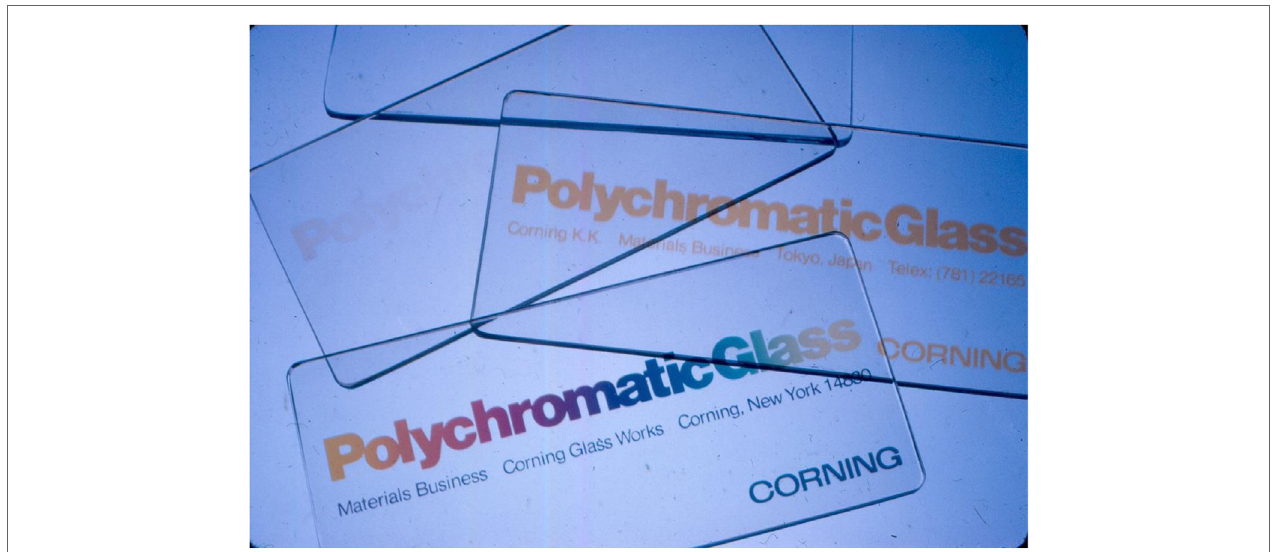
FiGURe 11 | evolution of polychromatic glass as formed, after ultraviolet exposure and first heating, and after second ultraviolet exposure and heating